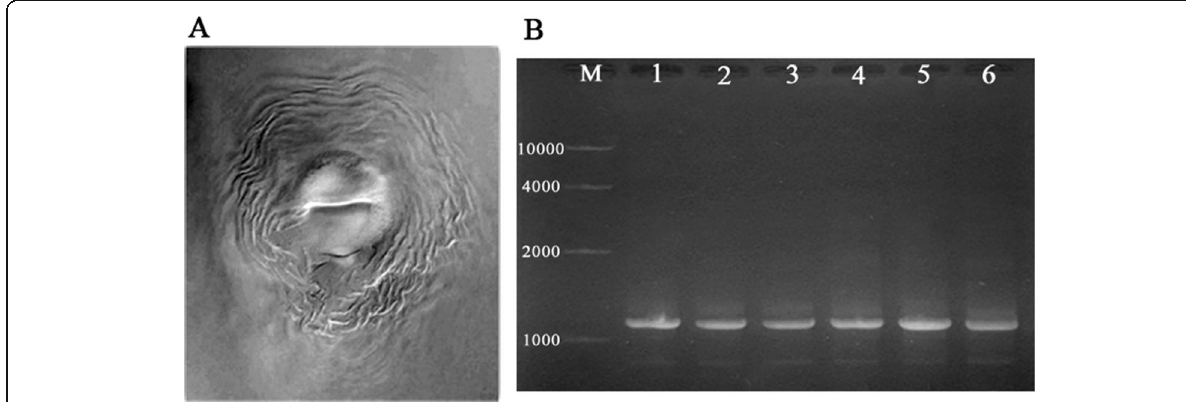
Fig. 1 Perineal pattern of Meloidogyne incognita a . Electrophorogram of PCR products: 1 – 6: PCR products using nematode genomic DNA as template DNA, in six replications b . M: GeneRuler TM High Range DNA Ladder,